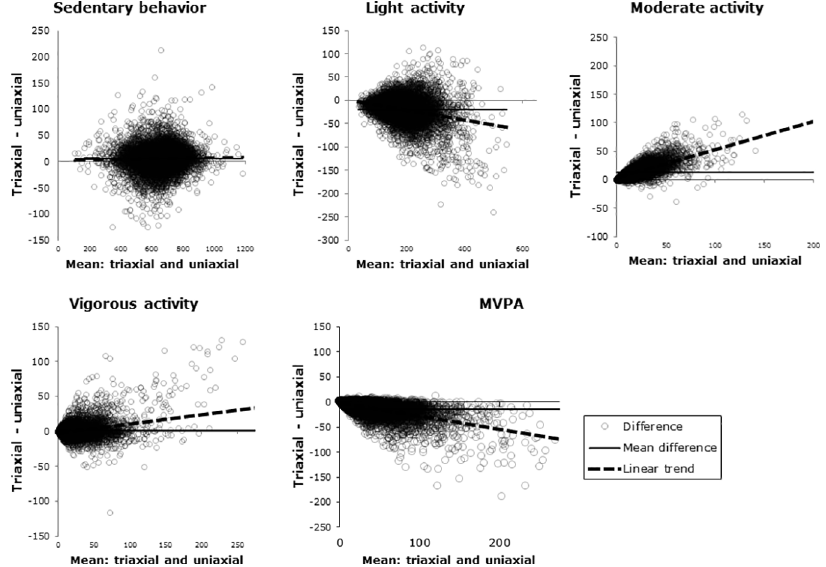
Fig 1. Large differences in estimated activity intensity between uni- and triaxial accelerometric cutpoints originally calibrated to the samedataset. Romanzini’suni- and triaxialcutpoints from Romanzini M; Petroski, EL; Ohara, D; Dourado, AC; Reichert, FF. Calibration of ActiGraph GT3X, Actical and RT3 accelerometers in adolescents. EuropeanJournal of Sport Science. 2014;14(1):91–9. doi: 10.1080/